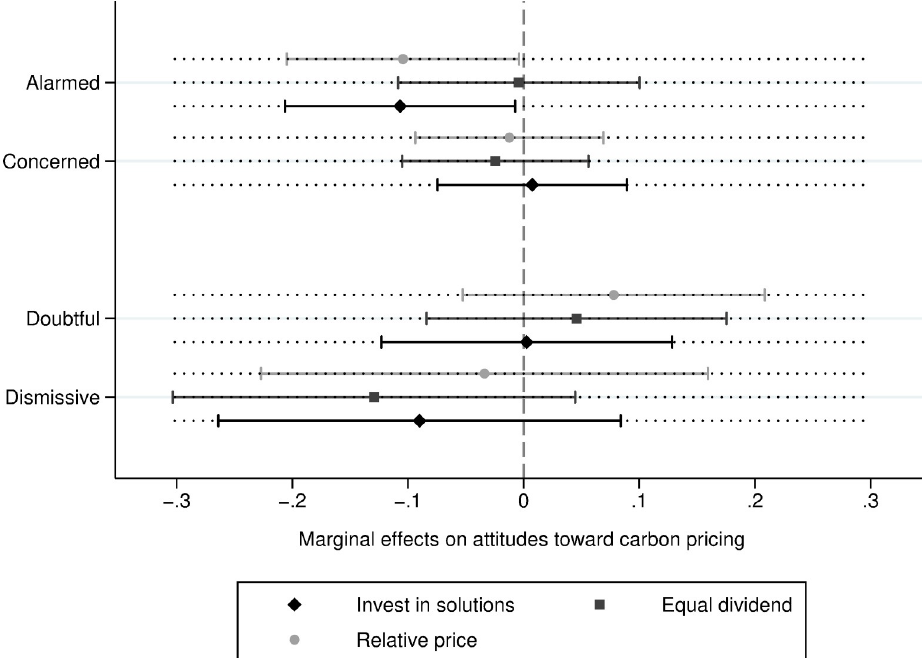
Fig 1. Marginal effect of emphasis framing on attitudes toward carbon pricing under low price specification, conditional on the Five Canadas (95% Cis).